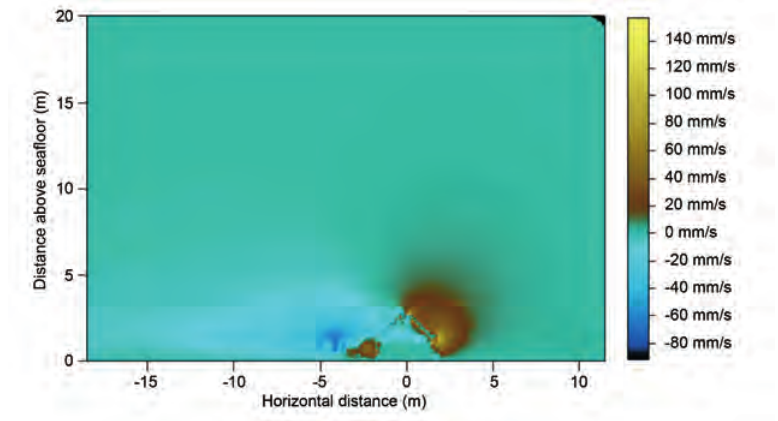
Fig. 4b. Vertical velocity in a plane through the centre of the observatory with a far-field speed of 300 mm/s along a diagonal. Note that current is coming from the